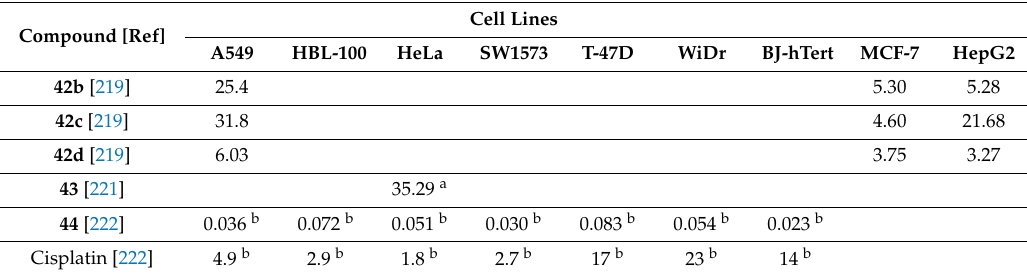
Table 12. IC 50 values ( µ M) for zinc complex 42b – d , 43 and 44 against di ff erent tumor and normal (Bj-hTert) cell lines, after an incubation time of 48